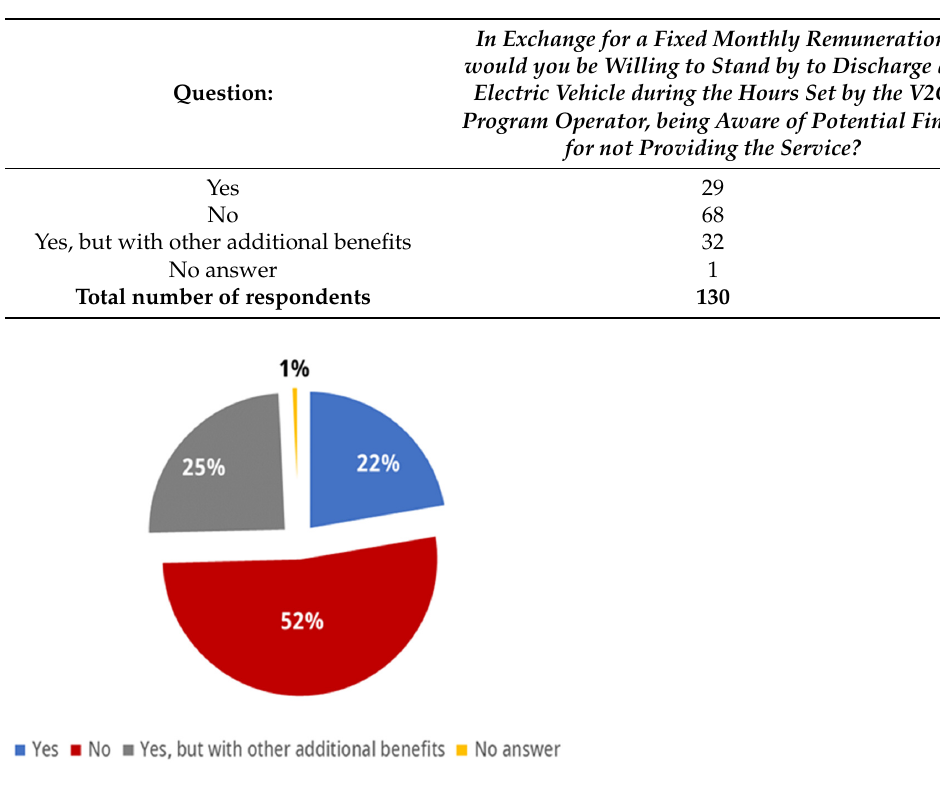
Table A10. Detailed responses to question (17).